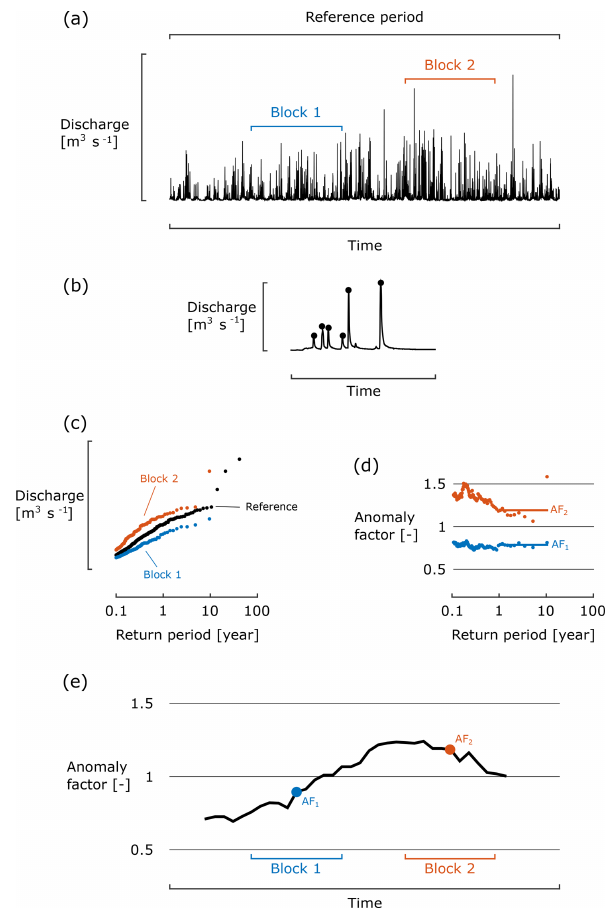
Figure 2. Schematic overview of methodology for estimating peak- flow anomalies for two specific block periods over a reference pe- riod. (a) Hourly discharge data with indication of two block periods and one reference period; (b) selection of peak flows. (c) Extreme value distribution of peak flows for two block periods and one refer- ence period; (d) anomaly factors for the two block periods as a func- tion of return period and average anomaly factor for return periods larger than 1 year for the two block periods. (e) Average anomaly factors over time, with the average anomaly factors of the two block periods